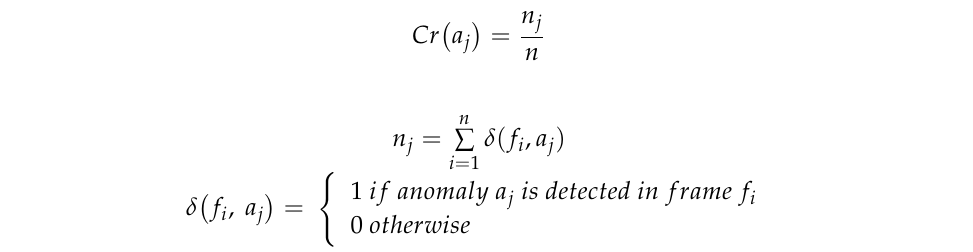
Figure 6. Example of image classification.